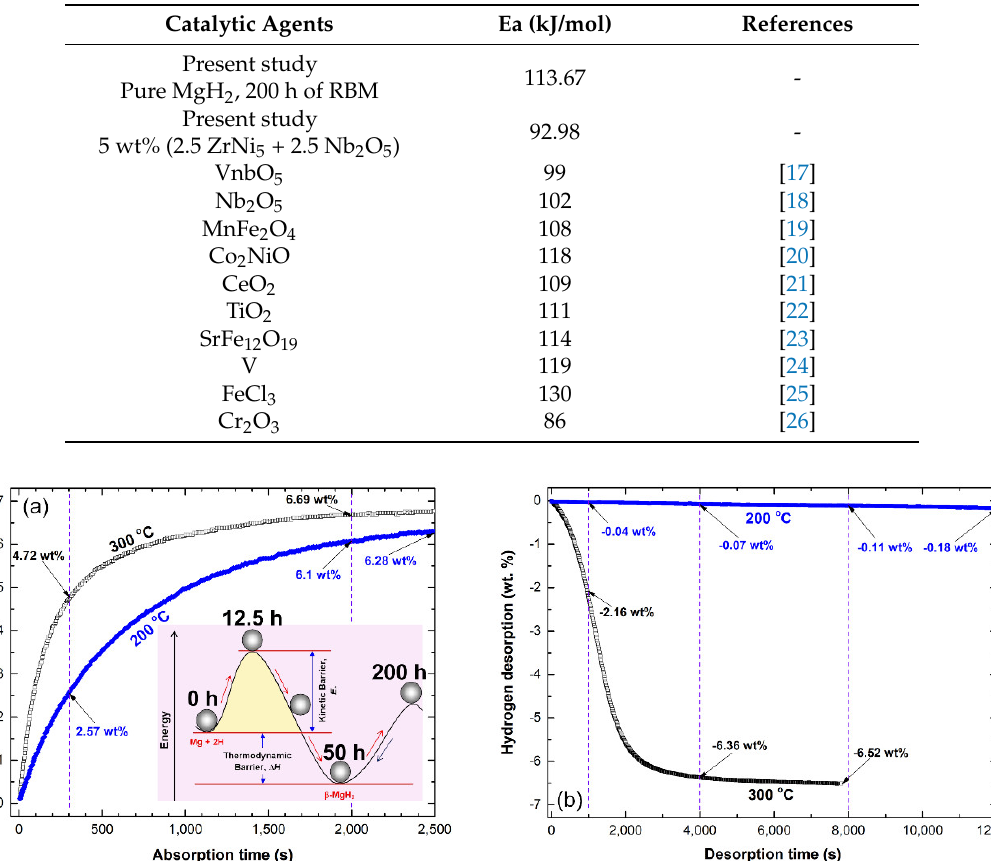
Table 2. Apparent Activation energy (Ea) of Decomposition for MgH 2 Doped with Selected Catalysts.